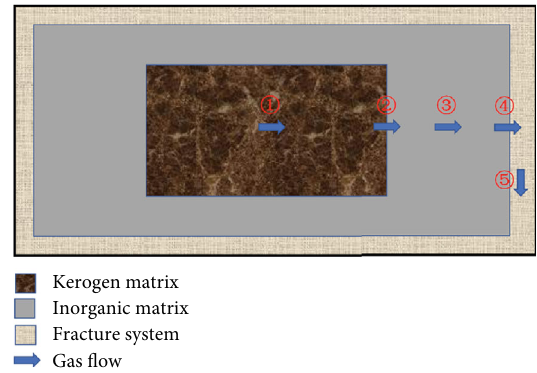
Figure 1: Schematic diagram of shale gas fl ow in multiple-porosity